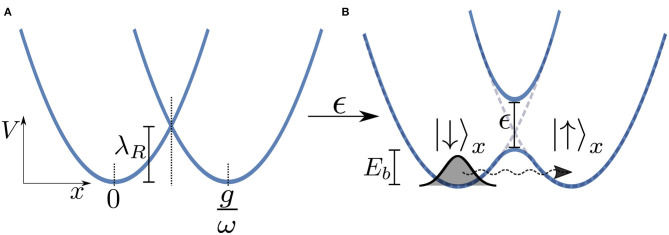
(A) Potential energy surfaces (Marcus parabolas) for ϵ = 0 as a function of the reaction coordinate x. We consider only the case of zero bias, i.e., when the minima of the two wells are at the same energy. (B) Turning the electronic coupling ϵ leads to an avoided crossing and thus an energy barrier Eb for the reaction. Note that this is a simplified picture in which we treat the bath as being represented by a single mode of frequency ω and coupling strength g whereas in the actual model we simulate there is a similar surface for all bath modes.